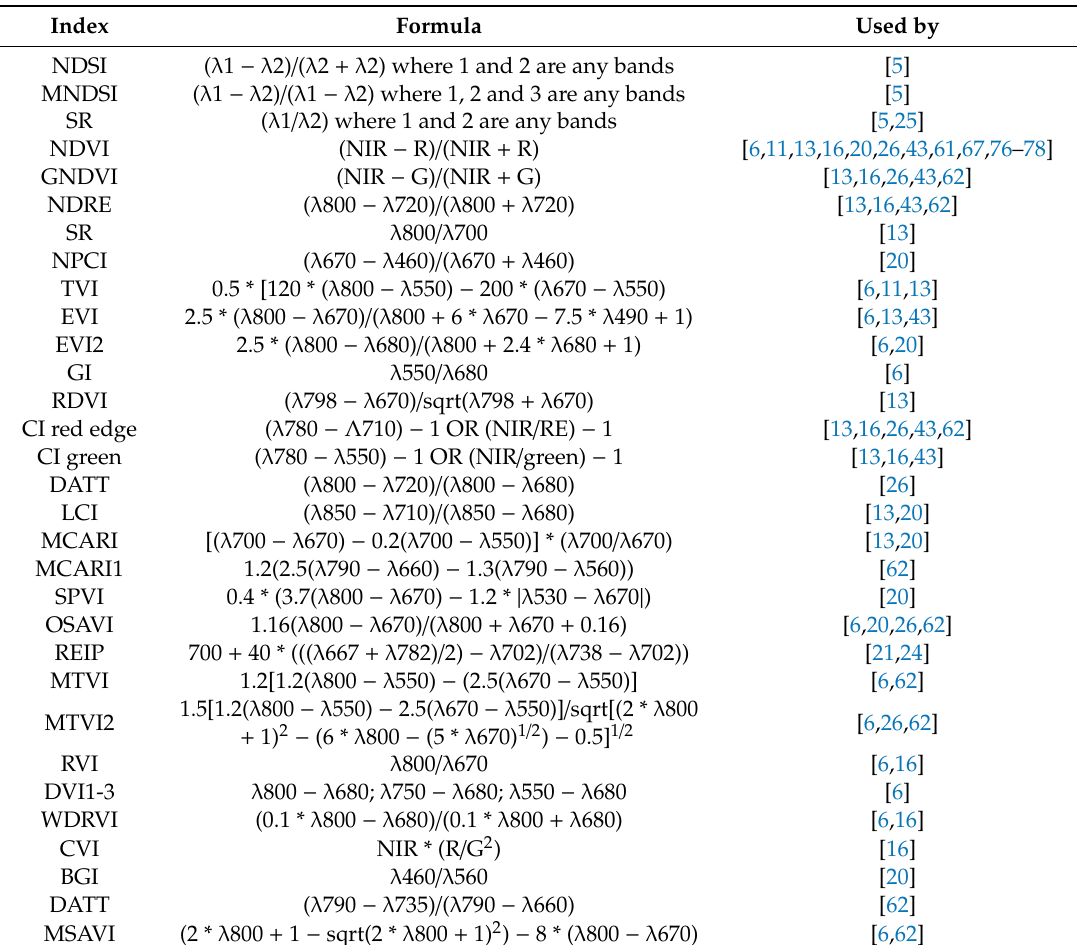
Table 2. All multispectral or hyperspectral vegetation indices used to model vegetation biomass in at least one of the studies included in this review. R, G, B and near infrared (NIR) indicate the measured reflectance (digital numbers) in red, green, blue and near-infrared wavelength ranges, respectively. Λ is used to indicate the reflectance at the given specific